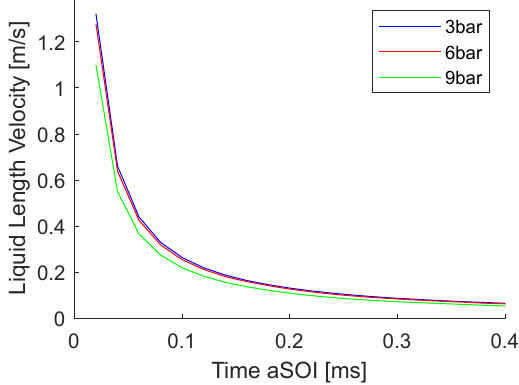
Figure 9. Spray tip penetration velocity.